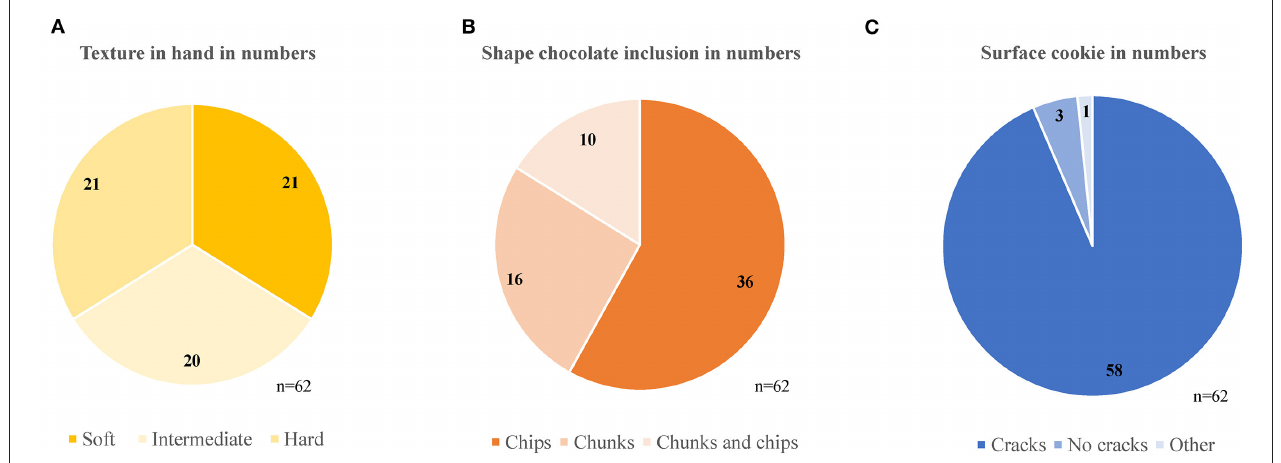
FIGURE 4 | Results of the three sensory screenings on all 62 chocolate chip cookies with the additional ranked criteria (A) texture in hand, (B) shape of the chocolate inclusion and, (C) the surface of the cookie. Those three criteria are part of the 11 additional ranked criteria in order to be able to make an informed subset selection which is representative of the market.